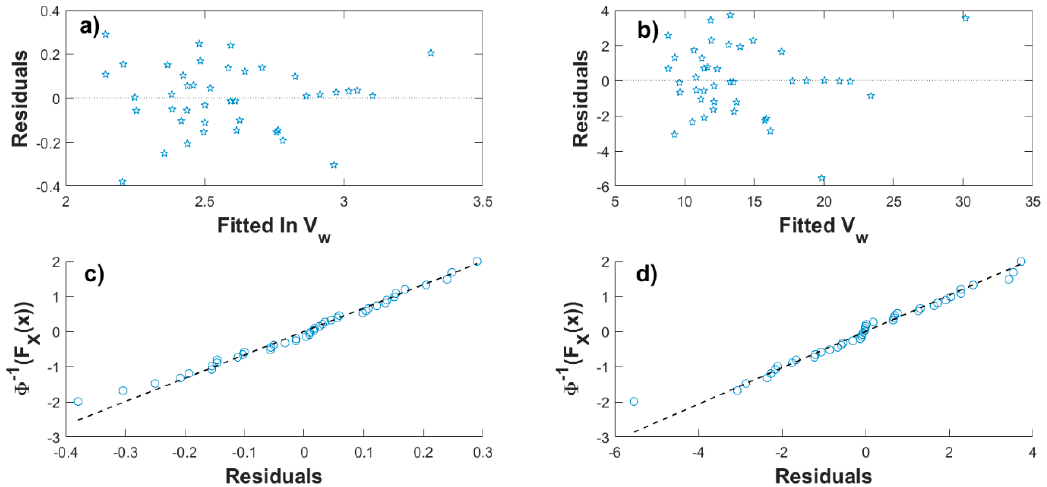
Figure 8. Residuals and normal probability papers including T -yr values in the regression: ( a , c ) for the logarithmic case and ( b , d ) for the linear case.